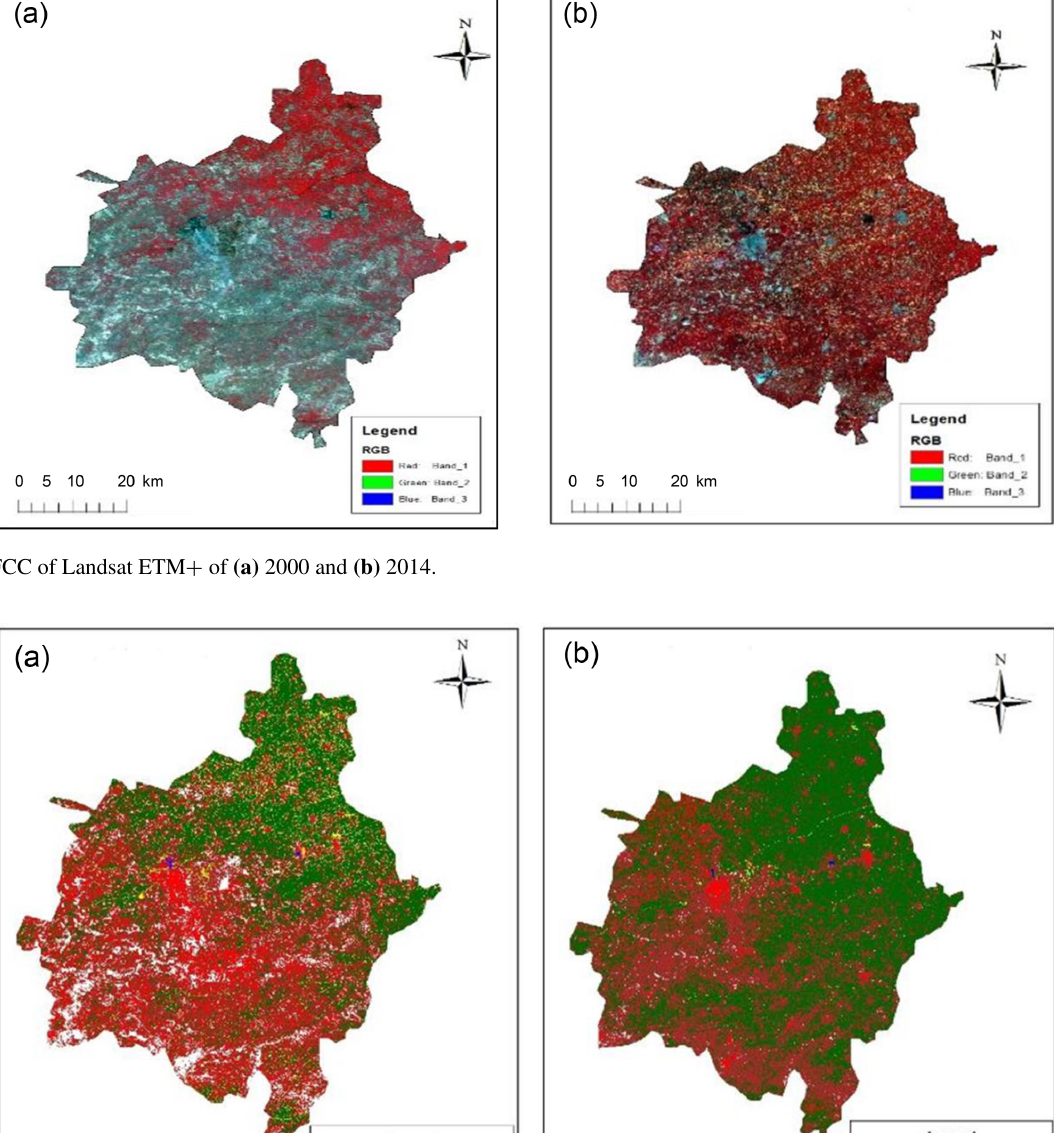
lowest in the military cantonment (pH = 7 . 37) and highest in Jaisingh Walla (pH = 8 . 59) in the study area (Table